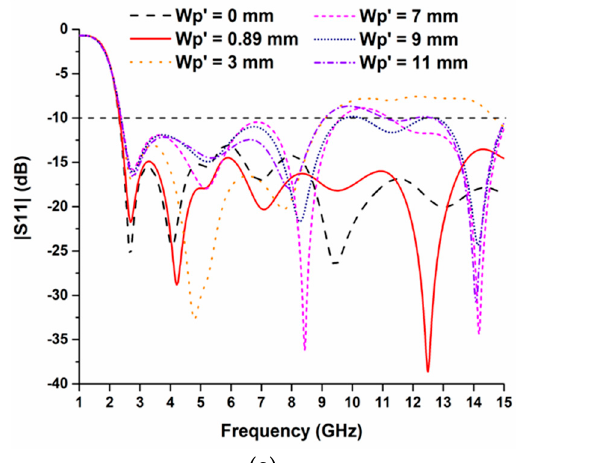
5 of 19 Table 1. Optimized parameters of the modified UWB antenna. Parameter